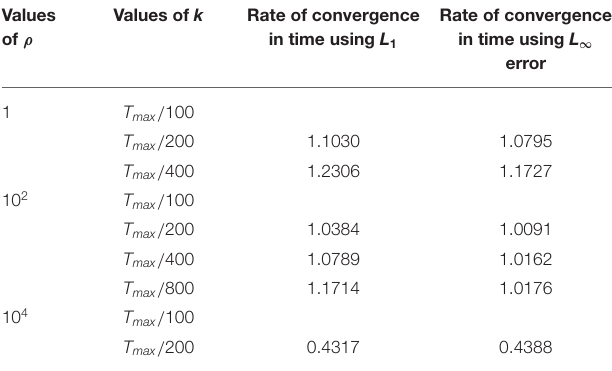
TABLE 6 | Rate of convergence in time for EEFD using different values of ρ at time, T max 2.5 10 − 3 with h = × =